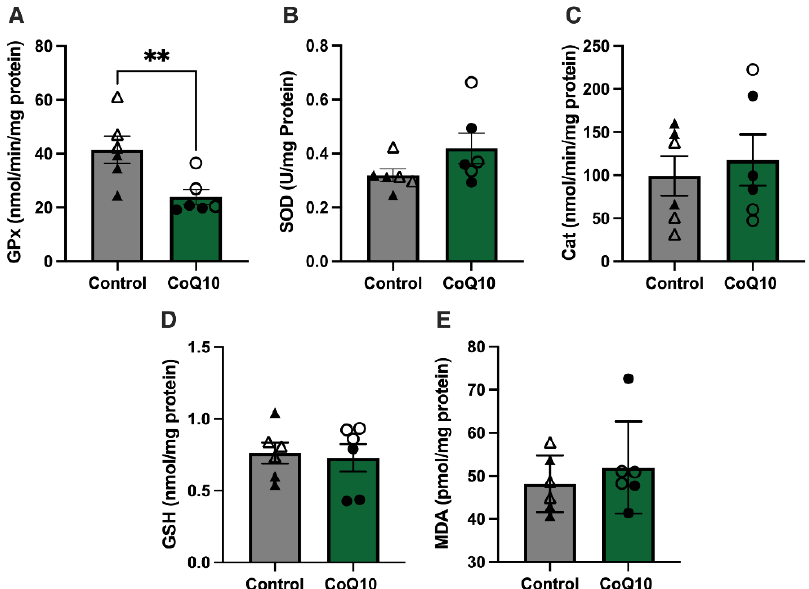
Figure 5. Skeletal muscle antioxidant activities and MDA concentrations relative to protein concen- trations. ( A ) Activity of GPx in control and CoQ10 treatment groups. GPx activity was significantly lower in the CoQ10 supplemented horses ( p = 0.003). ( B ) Activities of SOD in control and CoQ10 treatment groups were not significantly different with treatment ( p = 0.17). ( C ) Activities of Cat in control and CoQ10 treatment groups were not significantly different with treatment ( p = 0.66). ( D ) GSH concentrations in control and CoQ10 treatment groups were not significantly different ( p = 0.75). ( E ) MDA concentrations in control and CoQ10 treatment groups were not significantly differ- ent ( p = 0.47). Open circles represent horses on the CoQ10 supplement during the first supplemen- tation period, and closed circles represent horses on the CoQ10 supplement during the second sup- plementation period. Open triangles represent horses on the control diet during the second supple- mentation period, and closed triangles represent horses on the control diet during the first supple- mentation period. ** p <0.01.